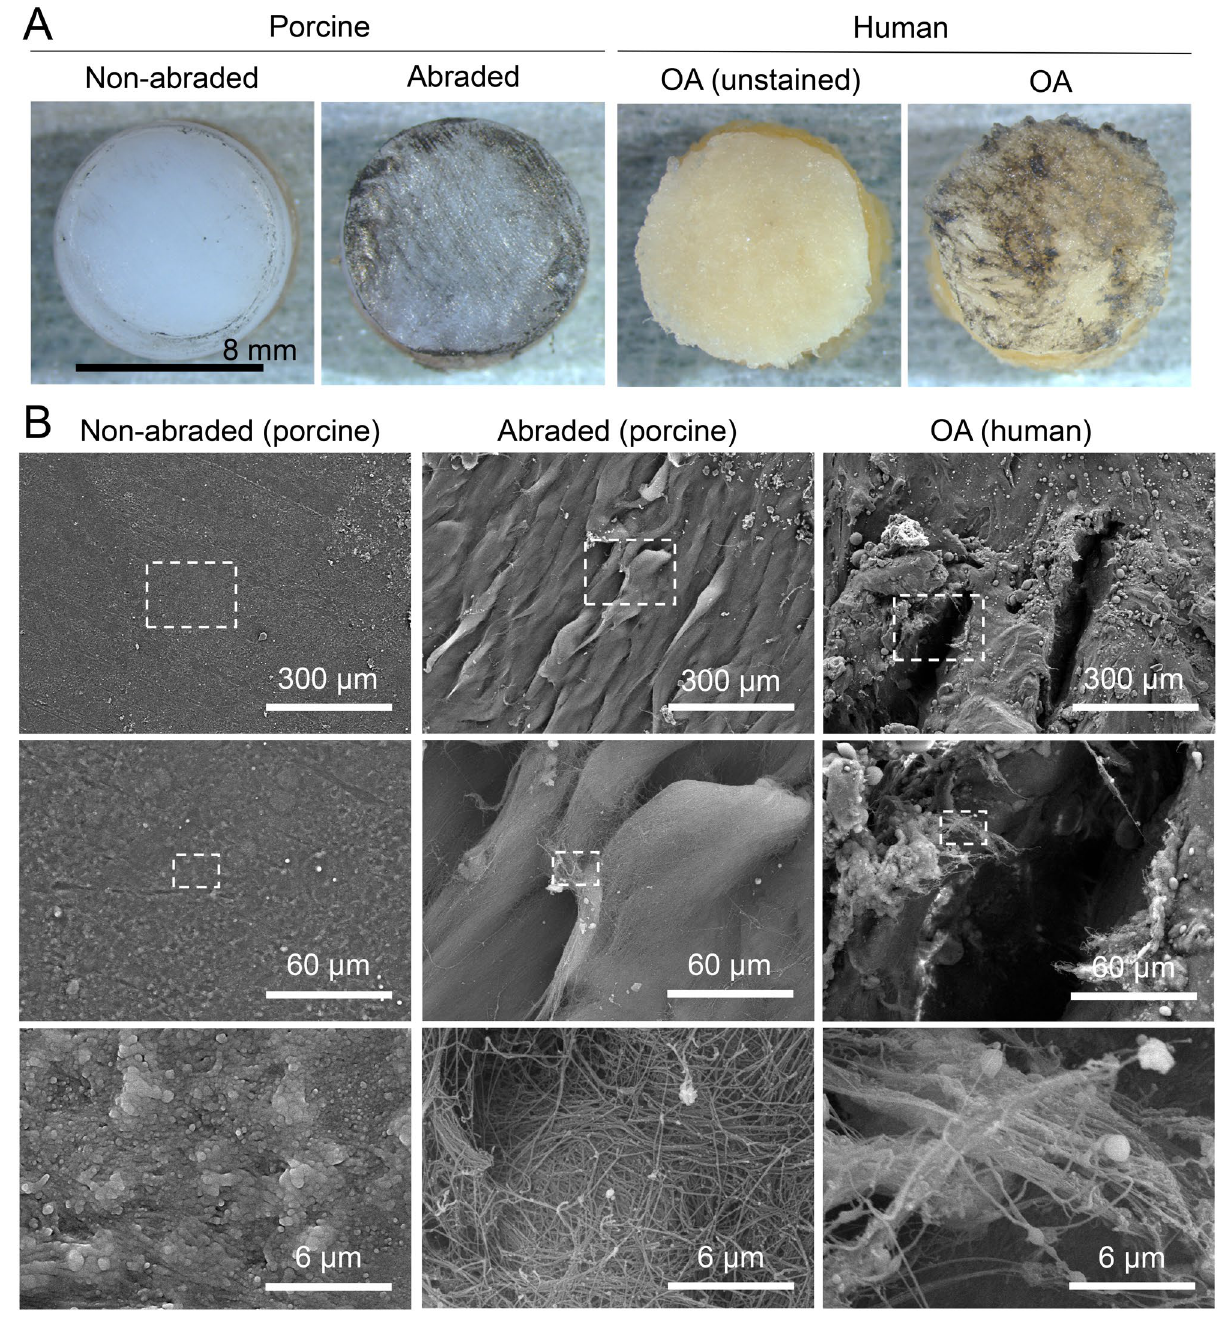
Figure 2. Surfaces of abraded porcine cartilage and human OA cartilage. ( A ) Gross appearances of the cartilage surfaces after staining with India ink. ( B ) Scanning electron microscopy images of the cartilage